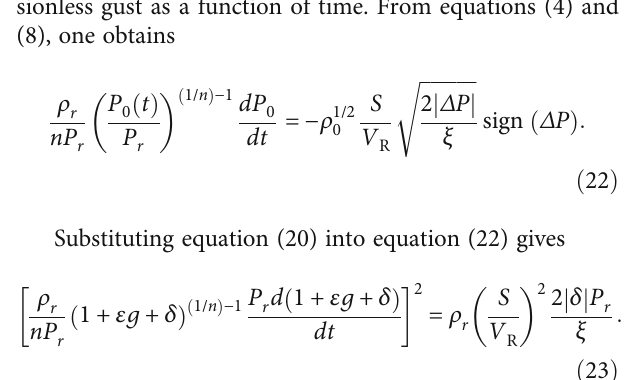
Figure 4: Variation of the measured pressure jump, Δ P E , theoretical pressure jump, Δ P T , and wind tunnel gust pressure, Δ P of time, t , measured in the experimental setup with f Gate signal high indicates that the rotating gate ’ s position closes the wind tunnel duct (minimum gusty wind speed), and R = 0 : 0033m 3 , Z = 10 ; T is the period of a cycle; pressure loss coe ffi cient ξ = 1 ; Z is a scale factor V R